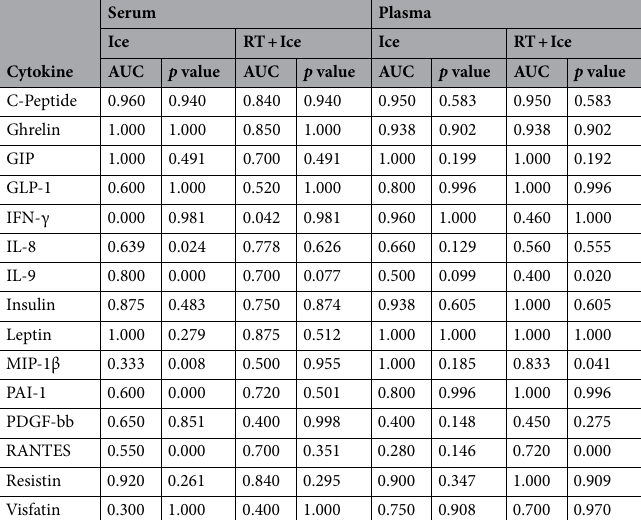
Table 2. Results of statistical and ROC classification analyses for each analyte, grouped by pre-processing condition. p values are for paired t-tests comparing the mean analyte levels in the reference protocol and the indicated